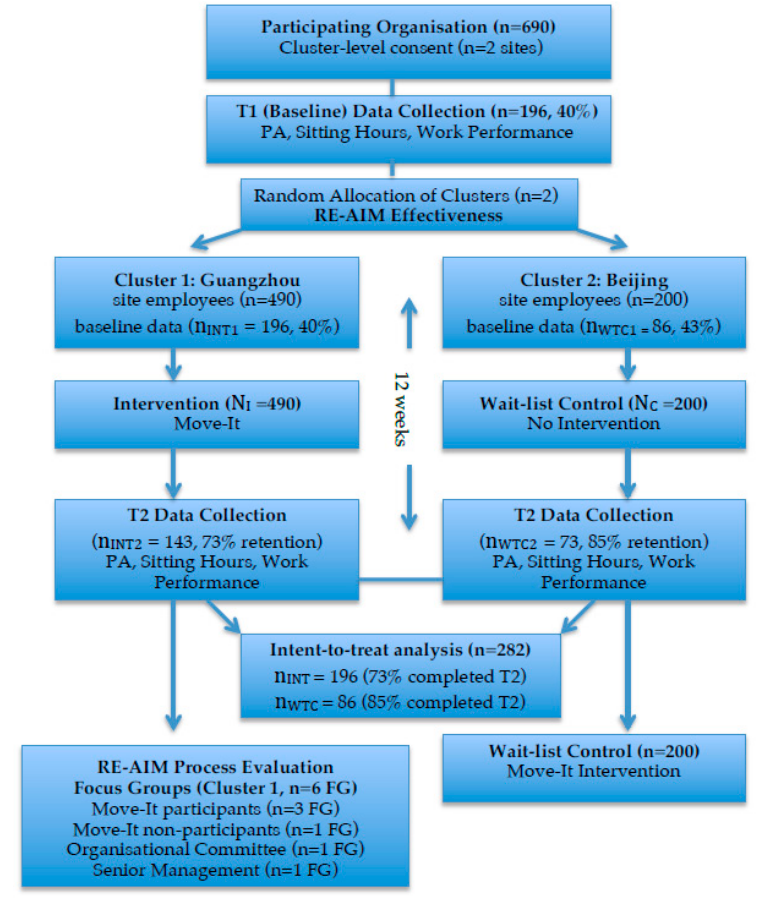
Figure 1. Study flow.